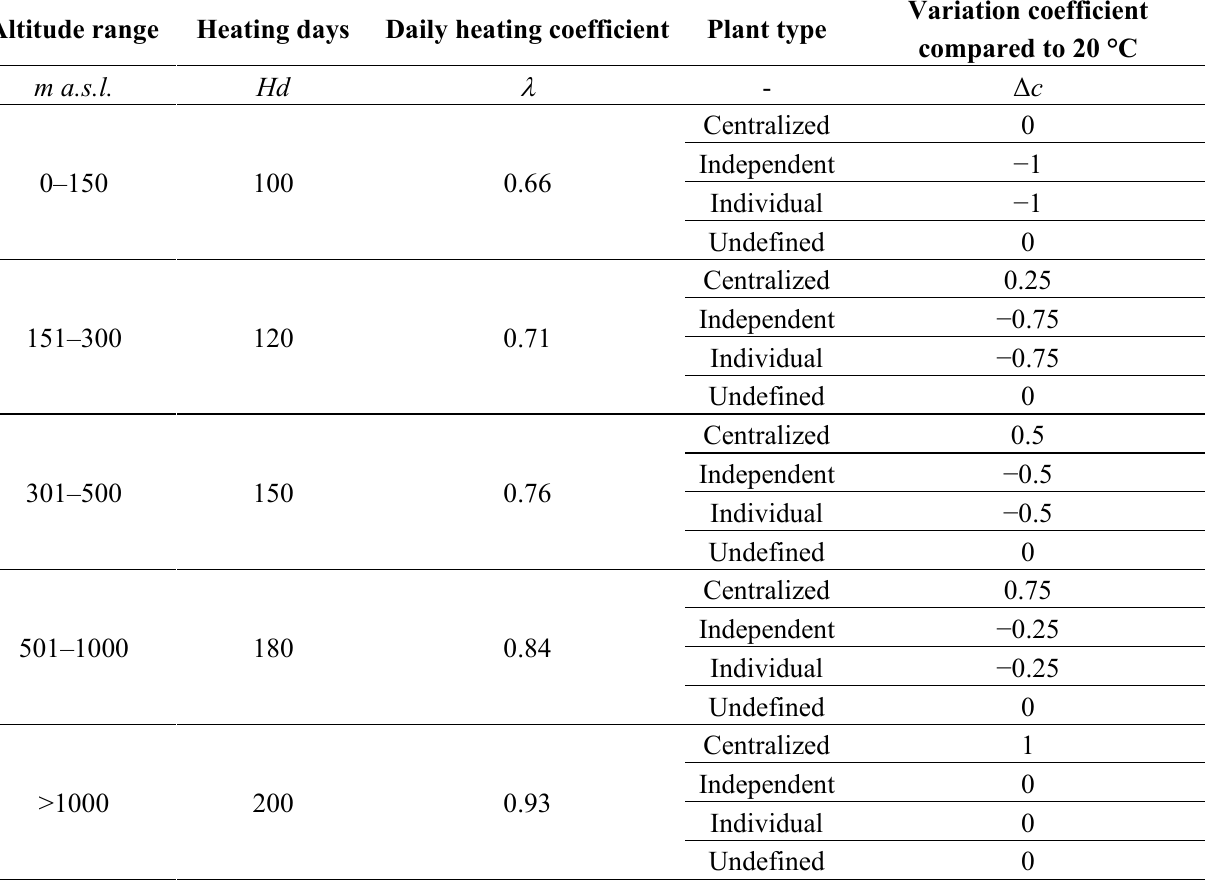
Table 2. Values of Hd , λ and Δ c used for calculating the annual energy requirement (AER) by plant. Source: